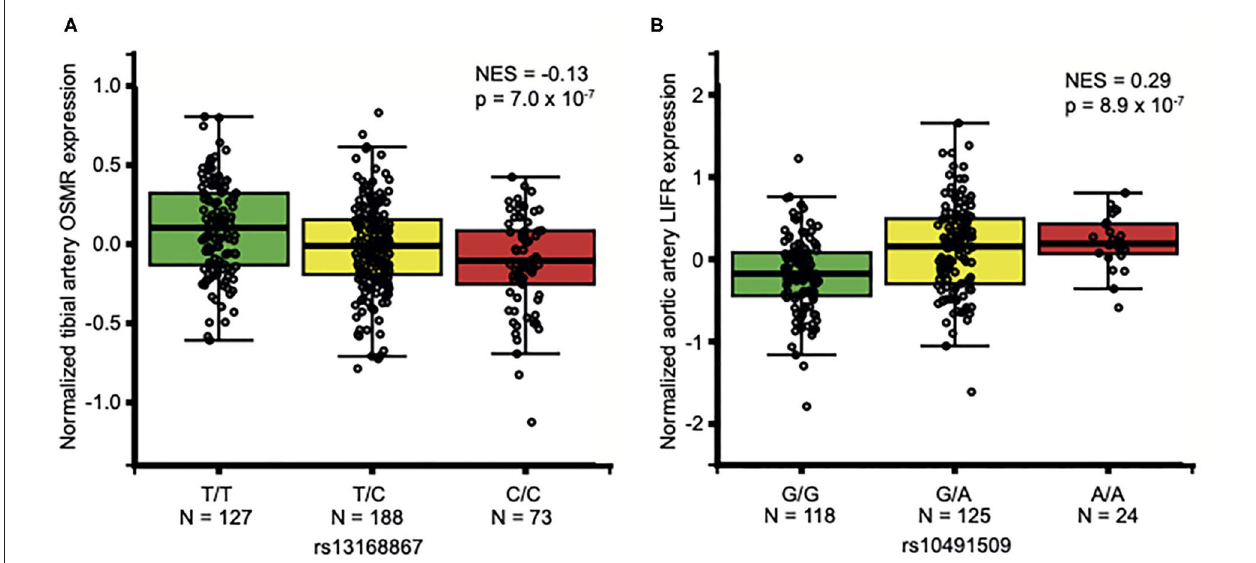
FIGURE 1 | Association of OSMR and LIFR variants in non-diseased arterial tissues. Per variant, the normalized expression of OSMR (A) and LIFR (B) is given in non-diseased arterial tissue. Data from GTEx Portal (www.gtexportal.org). NES: Normalized effect size. In aortic arterial tissue, rs13168867 had a NES of − 0.123 and in tibial arterial tissue, rs10491509 had a NES of 0.0881 ( Supplementary Figures 1 , 2